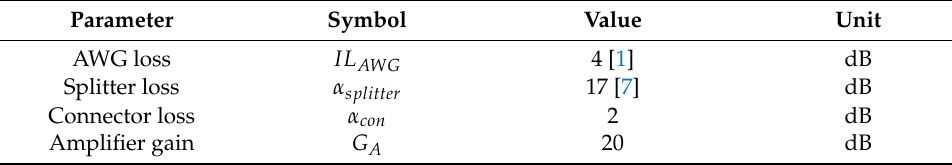
Table 4. Network parameters of the long-reach